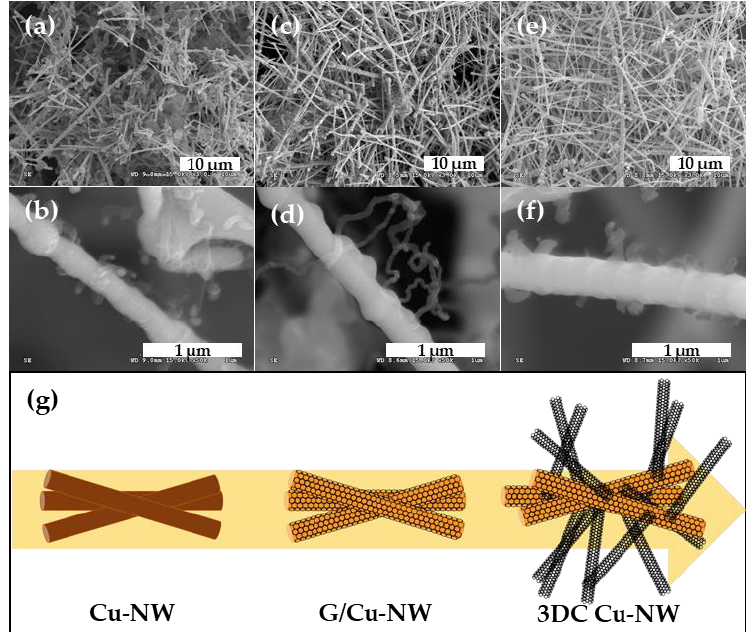
Figure 5. SEM images of carbon nanotubes (CNT) growth for Fe catalyst concentrations of ( a , b ) 7.5, ( c , d ) 12.5, and ( e , f ) 17.5 mg/L; ( g ) Schematic diagram of structural changes from Cu-NW to 3DC Cu- NW.